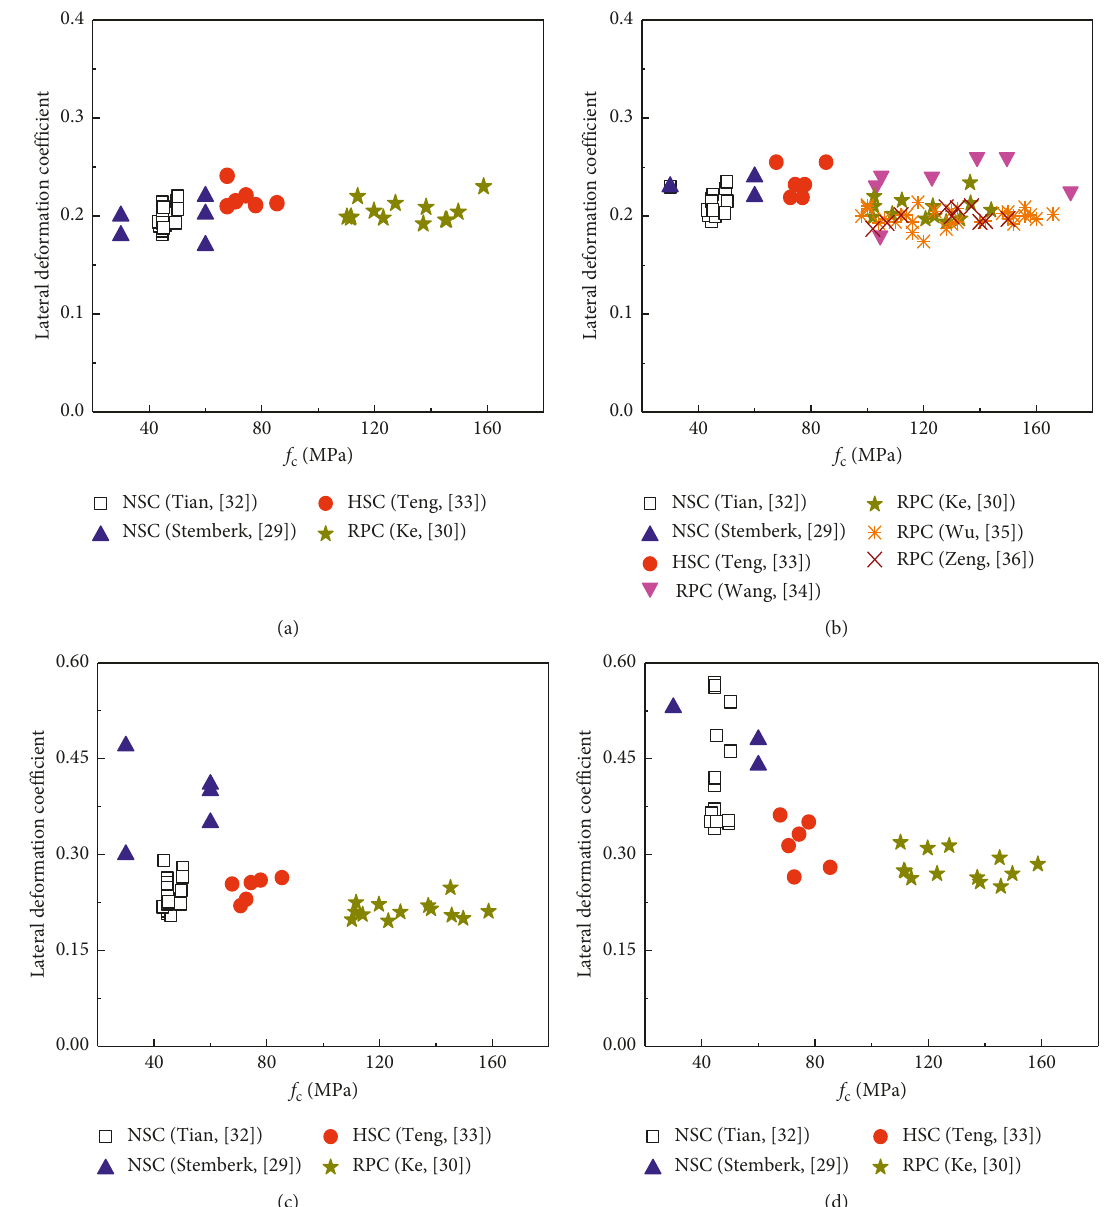
Figure 8: Lateral deformation coefficient of concrete for different strengths and different load levels. (a) σ (d) σ f c . (cid:31)